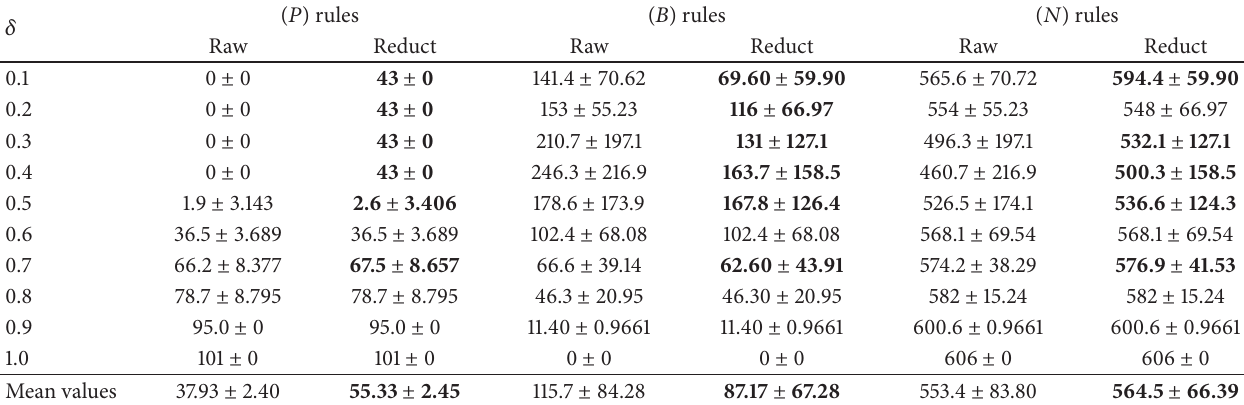
Table 5: The decision rules between raw data and decision-monotonicity criterion based reducts (Zoo).